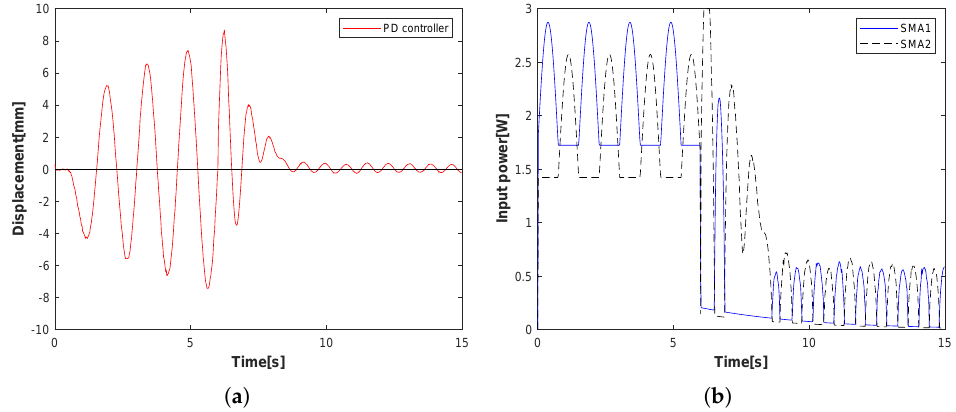
Figure 8. Experimental case 3: Vibration control with conventional PD controller. ( a ) Displacement of the flexible arm. ( b ) Input power of SMA